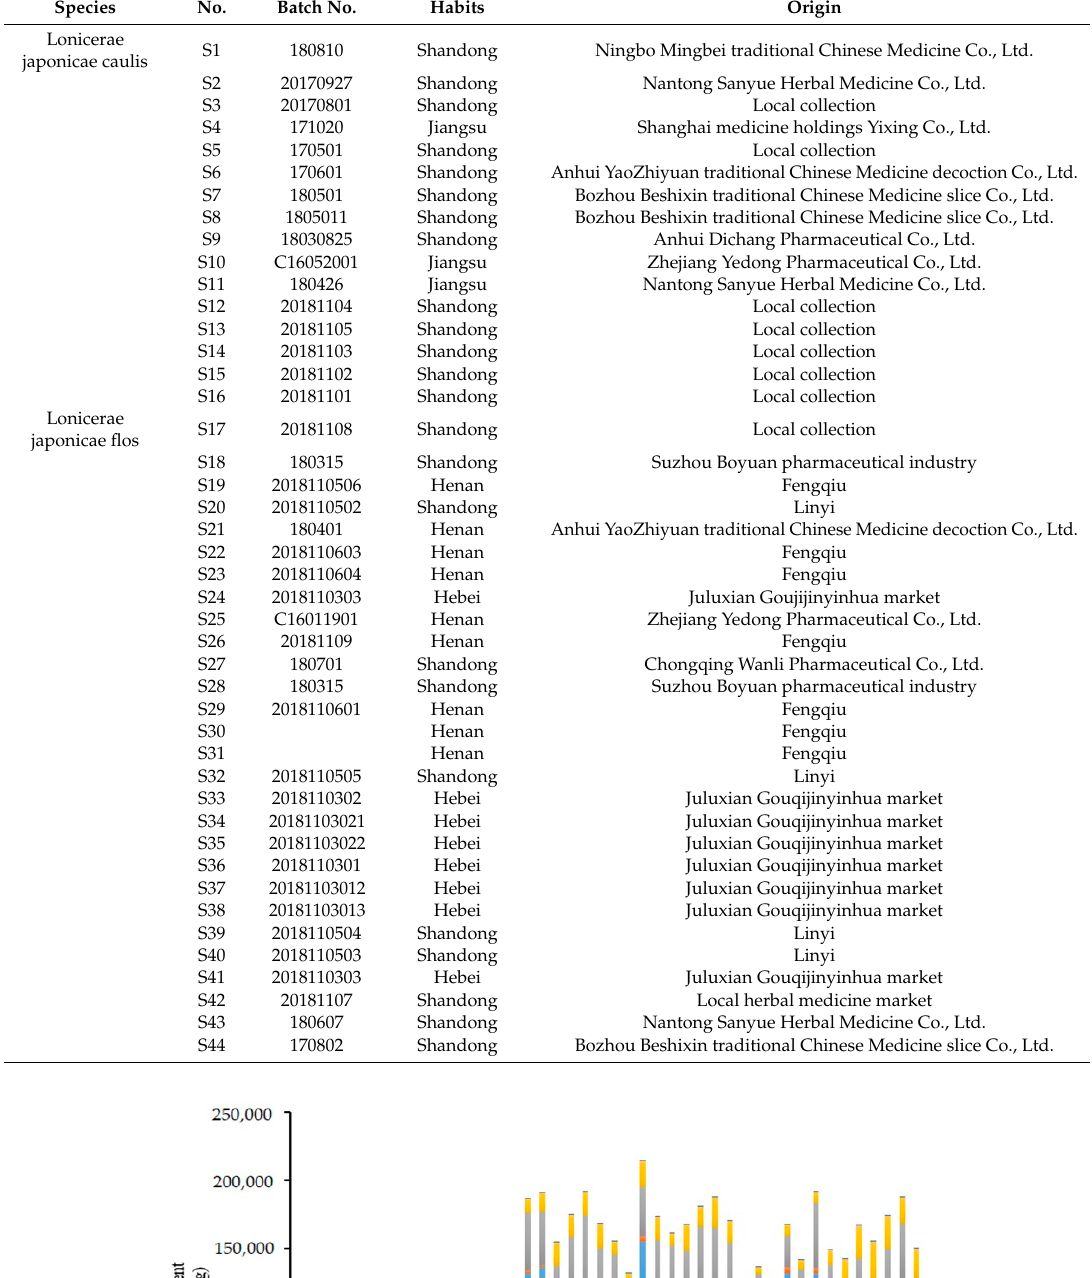
Table 4. Detailed information of samples.